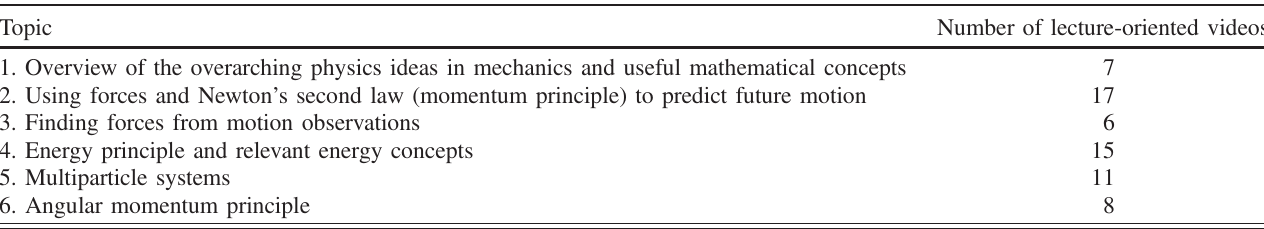
TABLE II. Major topic breakdown for lecture-oriented videos and the corresponding number of lecture-oriented videos for each topic. Topic